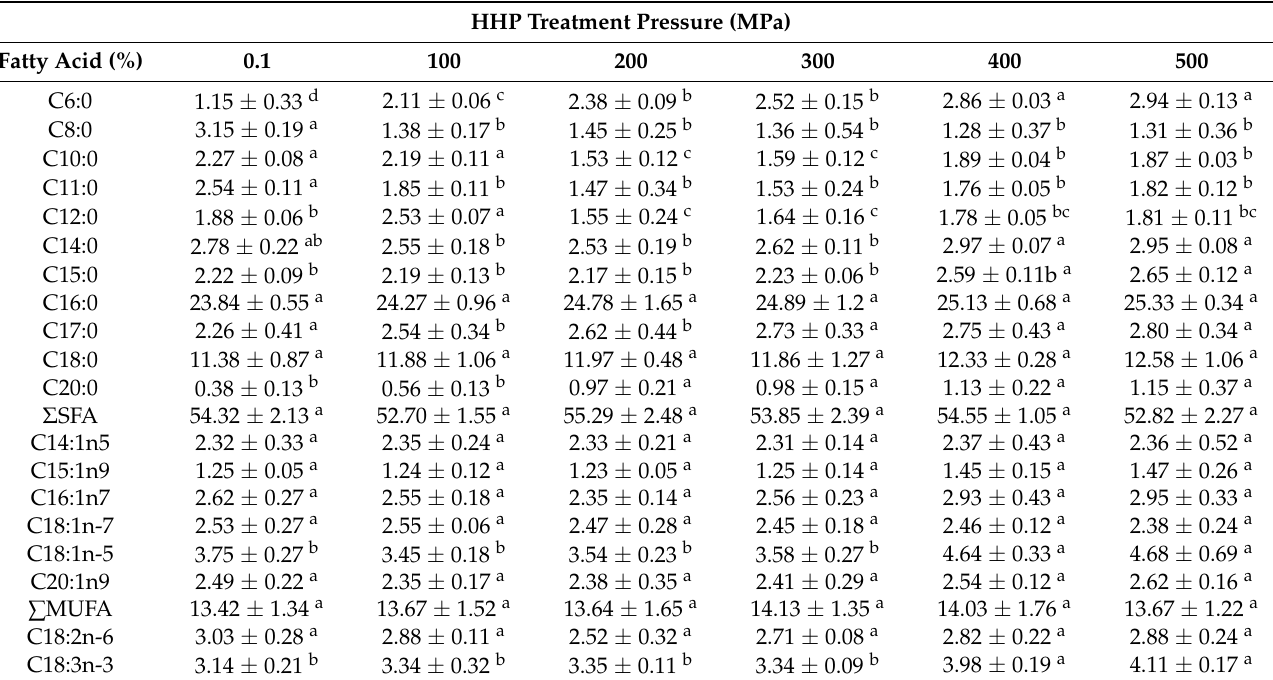
Table 3. Fatty acid profiles of oysters treated with different HHP